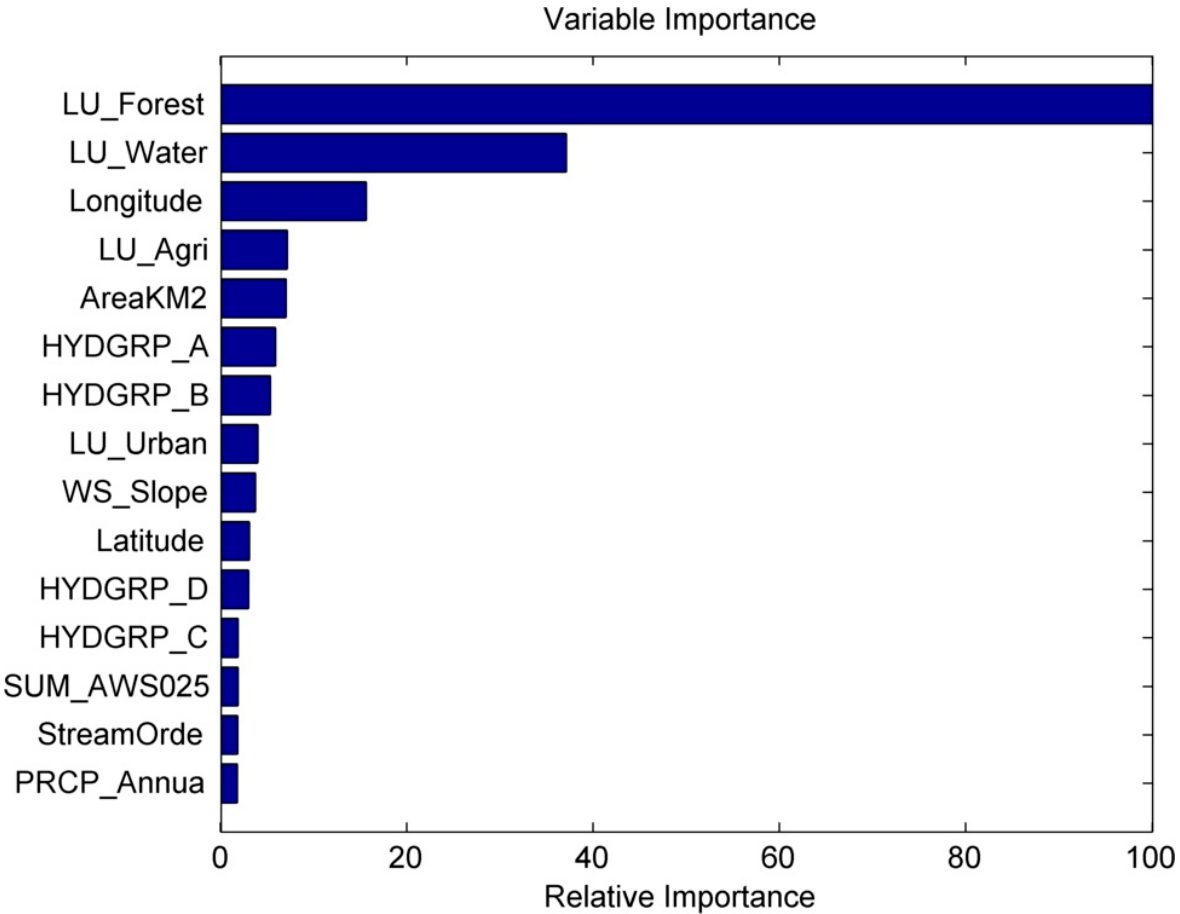
Figure 3. Variable importance for top 15 out of 81 explanatory variables according to random forest model trained on watershed health (with respect to SSC) at USGS-NAWQA stations.